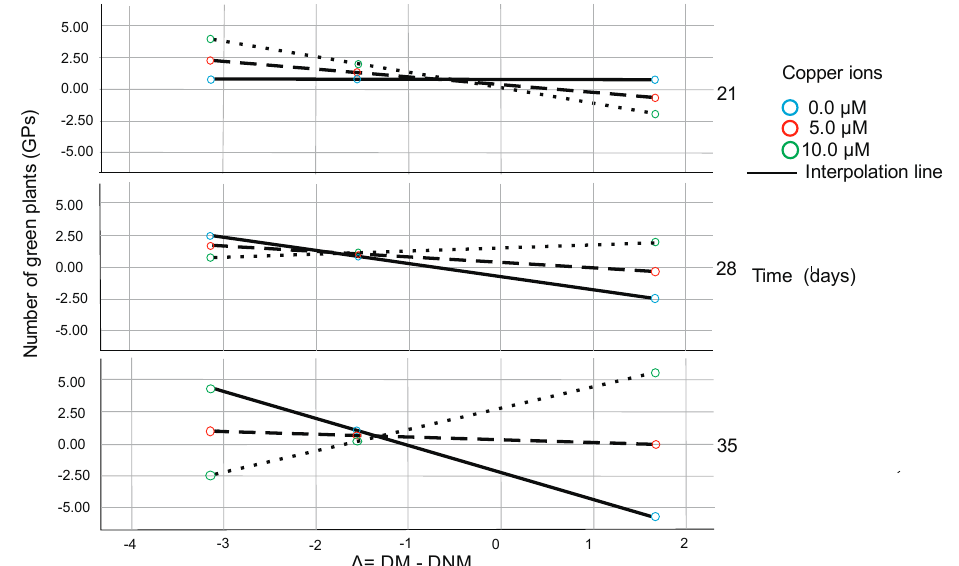
Figure 1. The conditional effect of Delta on the number of green plants (GPs) derived per 100 spikes as a function of copper ion concentration and Time of in vitro anther culture from moderated moderation model. Category axis (axis of abscissa) is indicated as Delta ( ∆ ). It illustrates values of Delta expressed as DM-DNM in percentage. Axis of ordinates reflects the number of green plants (GPs) regenerated per 100 anthers expressed in a number of regenerants. Blue, red and green circles indicate the different concentrations of copper ions.